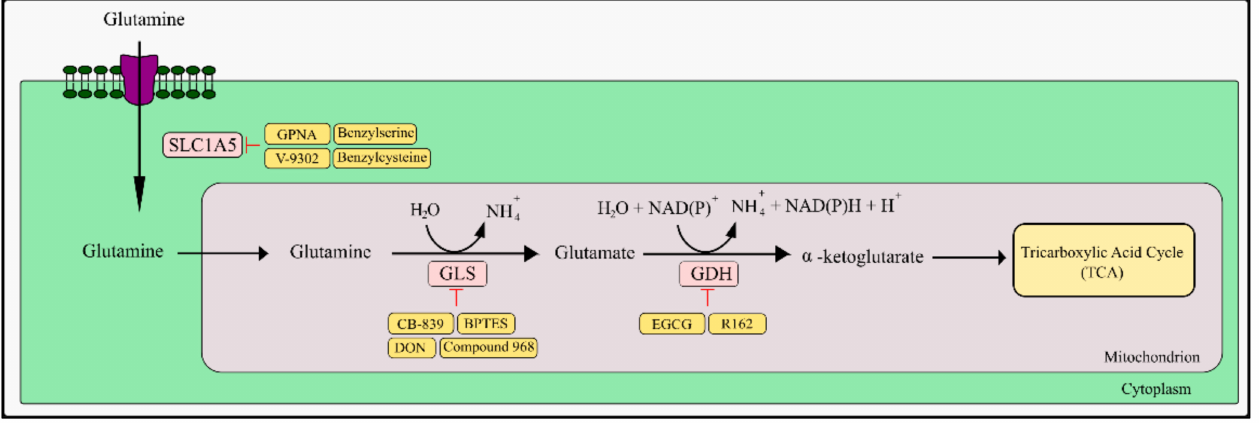
Figure 2. Schematic representation of glutamine transport, glutaminolysis pathway inhibitors, and its metabolic target. SLC1A5—glutamine transporter; GPNA—L- γ -glutamyl-p-nitroanilide; DON—6- diazo-5-oxo-L-norleucine; EGCG—epigallocatechin-3-gallate; GLS—glutaminase; GDH—glutamate